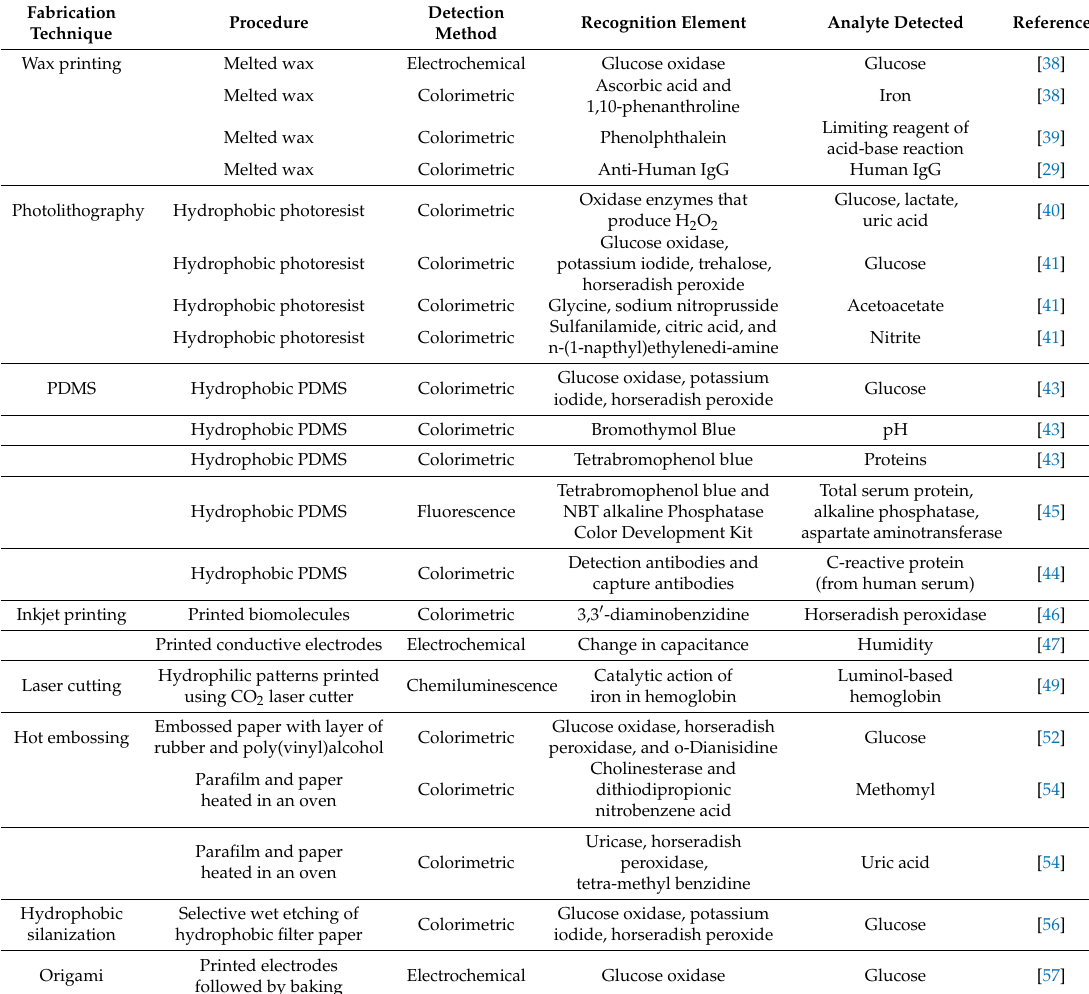
Table 2. Main fabrication techniques for paper-based